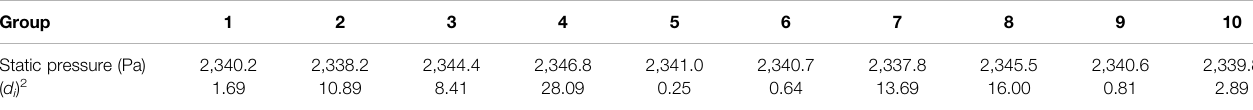
TABLE 1 | Static pressure data at the design fl